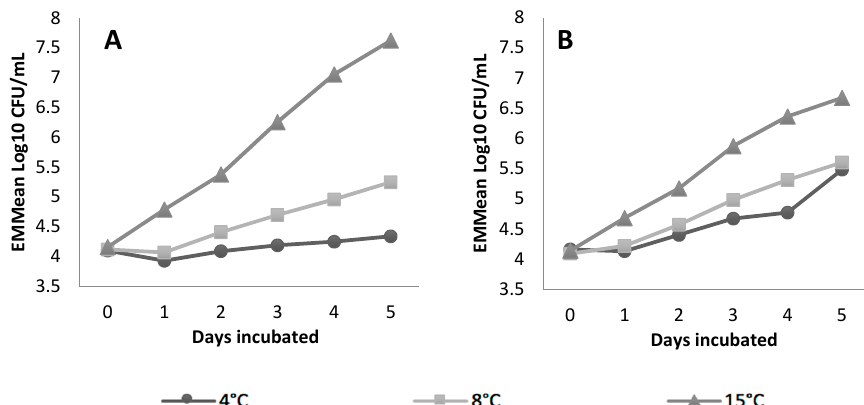
Figure 3. EMMeans of E. coli O157:H7 ( A ) and L. monocytogenes ( B ) concentrations at 4 °C, 8 °C and 15 °C over 5 days, statistically controlling for pathogen inoculum level.